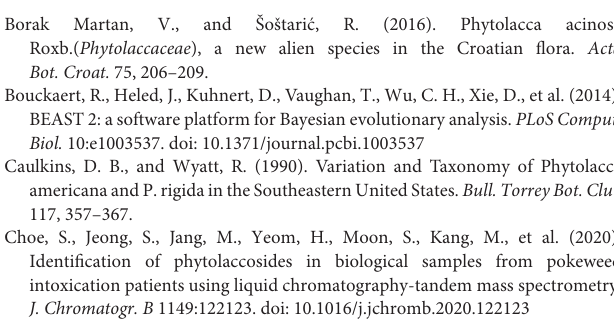
Supplementary Figure 1 | Map of the chloroplast genome of the genus Phytolacca. Supplementary Figure 2 | Pairwise genetic distances among Phytolacca species. Supplementary Figure 3 | Hypervariable regions within the chloroplast genome of Phytolacca species using sliding window analysis. Window lengths: 600 bp; step size: 50 bp. Nine regions with the highest Pi values were marked out. LSC, large single-copy region, IR, inverted repeat region, SSC, small single-copy region. x -axis: position of the midpoint of a window; y -axis: nucleotide diversity of each window. Supplementary Figure 4 | Frequency of SSRs in the Phytolacca chloroplast genomes. (A) The number of SSRs detected in the different Phytolacca species; (B) The number of SSR types in different Phytolacca species. Supplementary Figure 5 | Divergence times of Phytolacca obtained from BEAST analysis based on the 3g22s dataset. The mean divergence time of the nodes is shown next to the nodes, while the blue bars correspond to the 95% highest posterior density (HPD). Supplementary Figure 6 | Phylogenetic trees of Phytolacca based on the 3g22s dataset. ML bootstrap support values/Bayesian posterior probabilities were presented at each node. The infrageneric classification of the genus Phytolacca by Nowicke (1968) was mapped in the tree. The species which were not marked with the subgenus/section, were recently described or not accepted by Nowicke